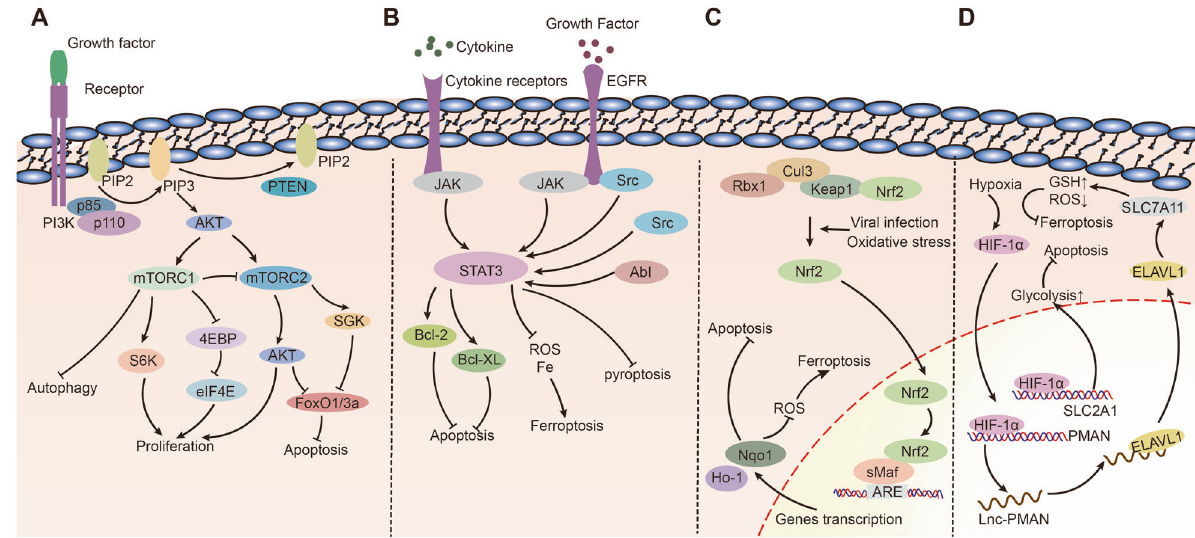
Fig. 4 Common pathways regulating cell death in gastric cancer. A PI3K/AKT/mTOR. B JAK/STAT3. C Keap1/Nrf2. D Hypoxia/HIF-1 α . protein divided into mTOR complex1(mTORC1) and mTOR complex 2(mTORC2) [71]. mTORC1 regulates the expression of downstream eIF4E by activating S6K and inhibiting 4EBP, thereby serine protein kinase with two phosphorylation sites (Thr308 and inhibiting autophagy and promoting cell growth. In contrast, Ser473) [70]. Phosphorylated AKT activates the mammalian target mTORC2 inhibits FoxO1/3a expression by activating SGK, thereby of rapamycin (mTOR) by directly phosphorylating mTOR or suppressing apoptosis [71]. In addition, AKT activation directly inactivating TSC2 [70]. mTOR is an evolutionarily highly conserved